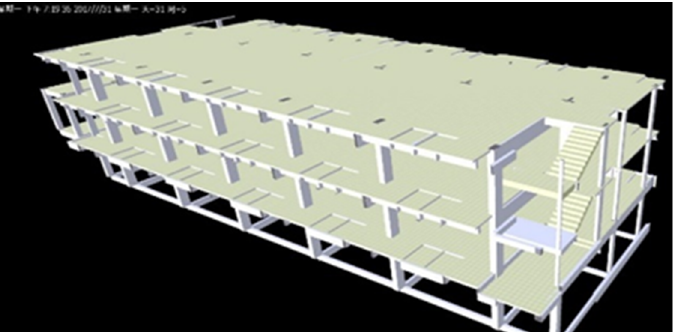
Figure 14. Project progress in week 4.